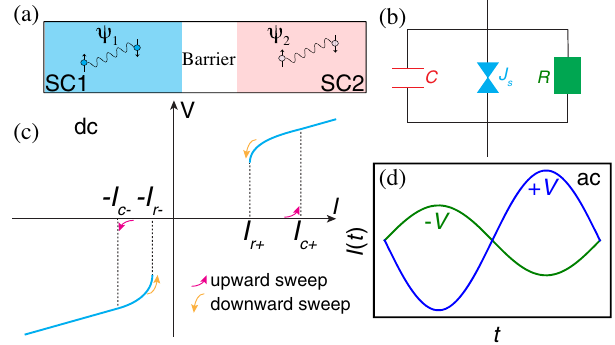
FIG. 1. (a) A Josephson junction is constructed by two SCs ψ 1 = 2 sandwiched with a tunneling barrier. (b) The physical Josephson junction can be modeled by an ideal Josephson junction J s shunted with a resistance and a capacitance. The capacitance leads to the hysteresis curve in I - V characteristic. (c) General I - V curves for a Josephson diode in a dc measure- ment. During the upward current sweep, there are two critical currents I c þ (positive direction) and − I c − (negative direction) from the SC regime to the dissipative regime, where I c þ ≠ I c − shows a diode effect. During the downward current sweep, there are also two return critical currents I r þ (positive direction) and − I r − (negative direction) from the dissipative regime to SC regime, where I r þ ≠ I r − shows another diode effect. (d), The diode effect in an ac Josephson junction, with I c ð V Þ ≠ I c ð − V Þ